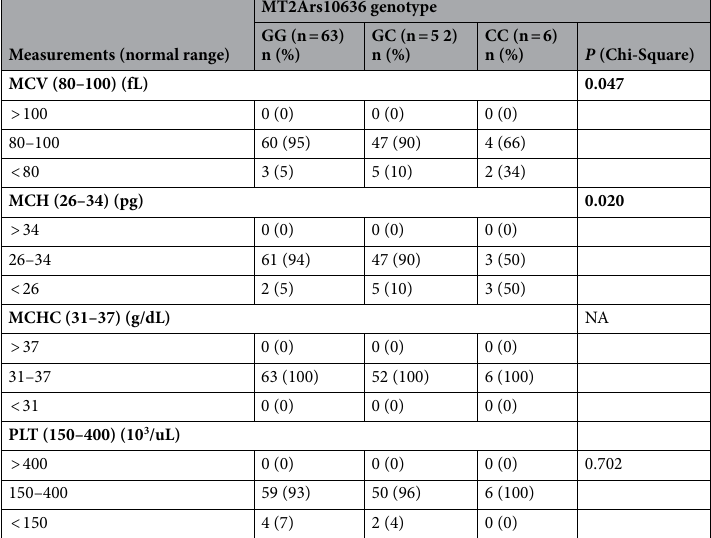
Measurements (normal